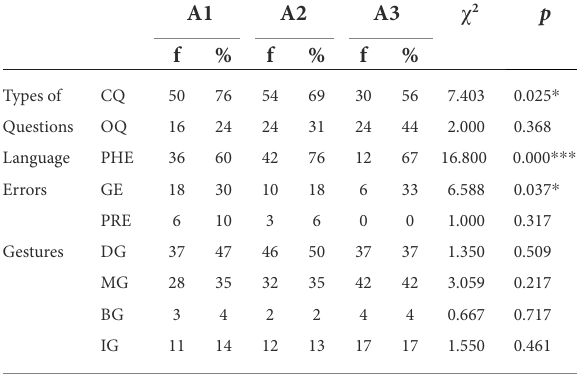
TABLE 6 Frequency changes in Teacher A’s three teaching sessions.